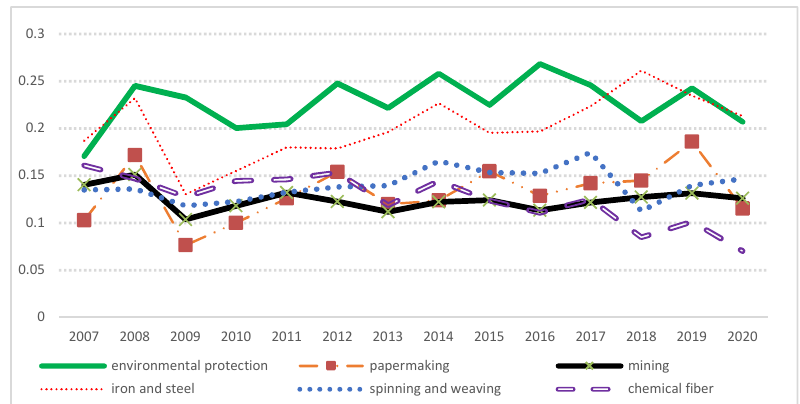
Figure 2. Interest-bearing debt interest rate: environmental protection industry and “Two High and One Surplus” industries.